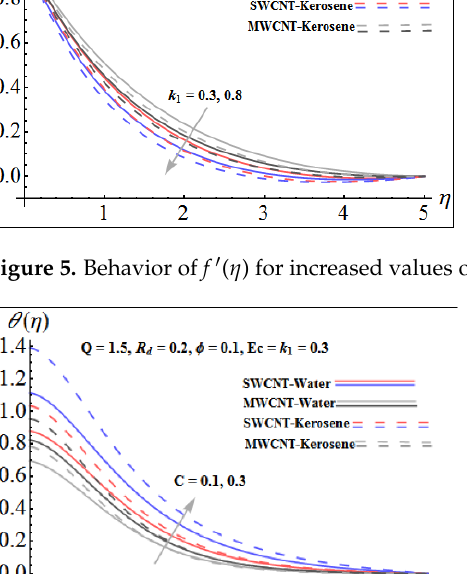
Figure 6. Behavior of θ ( η ) for increased values of C .